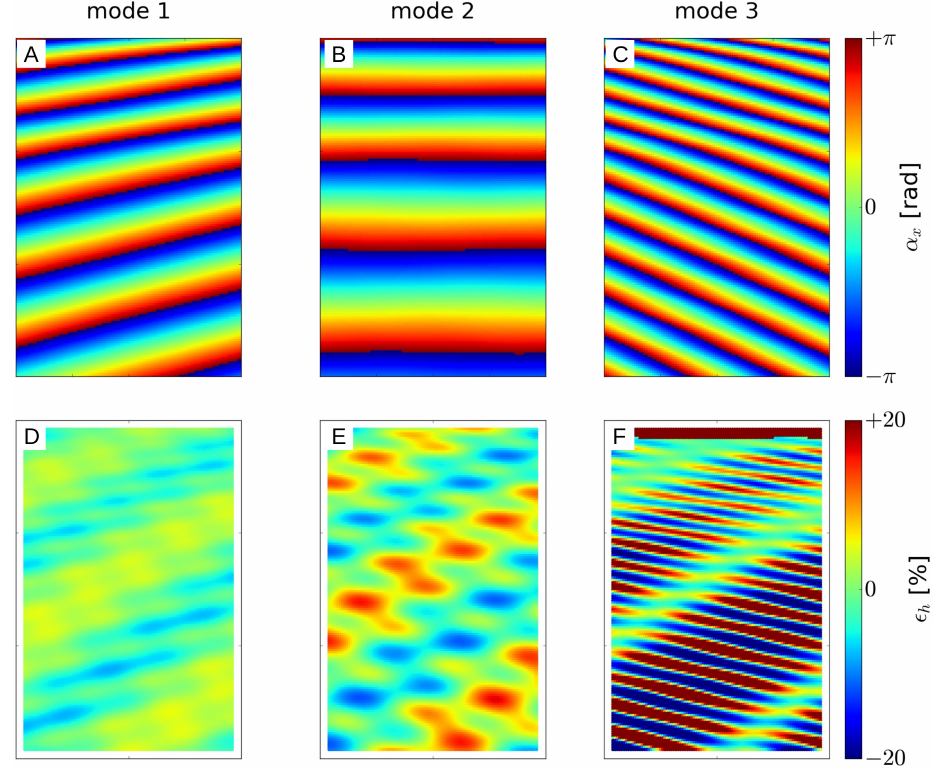
Figure 9. Phase fitting without windowing of the three modes of the linear polychromatic wave field WS for ∆ t = 0.5 s, ∆ x = 2 m, R t = 1 s, and R x = 8 m: α x ( A – C ) and (cid:101) h ( D – F